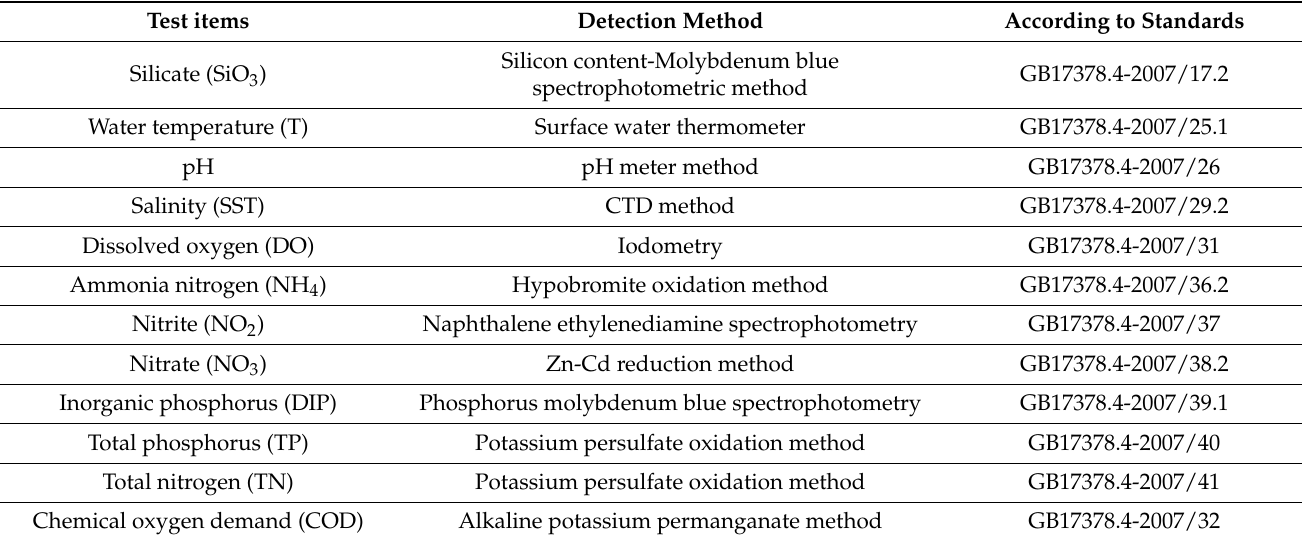
Table 1. Sampling methods to measure the environmental